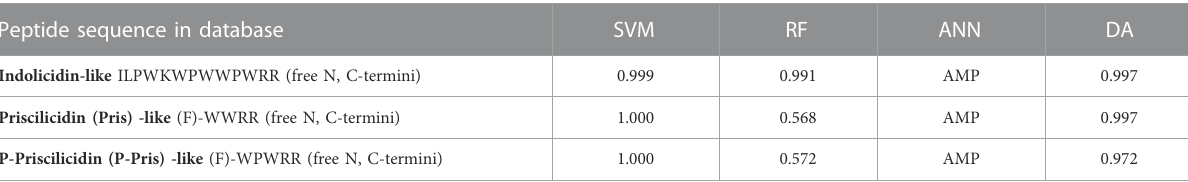
TABLE 2 Experimental antimicrobial activities of indolicidin (control), Priscilicidin (Fmoc-WWRR-NH2) and P-Priscilicidin (Fmoc-WPWRR-NH2) from minimum inhibitoryconcentrationassays (MIC) andveri fi ed by fl uorescence-assisted cell sorting assays (FACS)forthe most critical strains (results givenfor > 90%dead